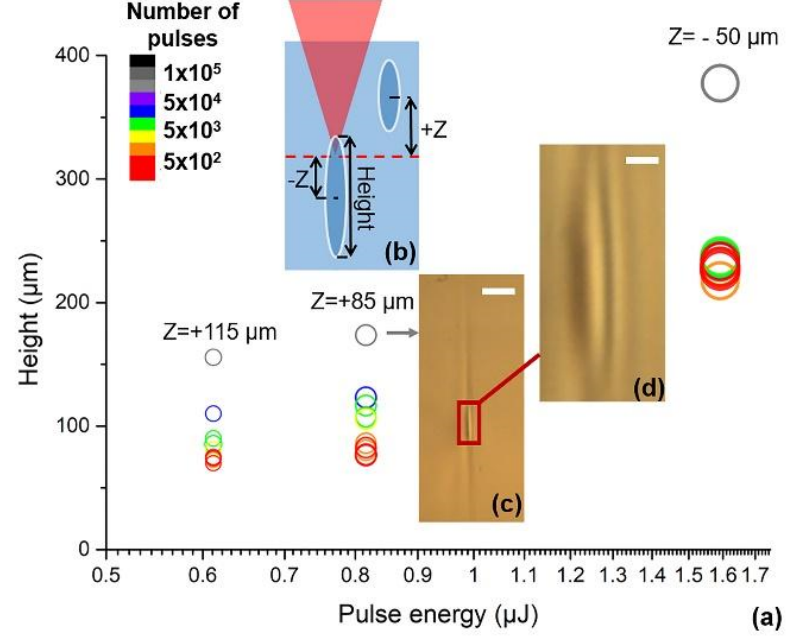
Figure 2. Measured height of waveguides at different pulse energy and number ( a ). Sketch map of laser inscribing and waveguide shift ( b ). The color legend of circles in ( a ) represents the number of laser pulses per region, where a smaller diameter means the maximum positive shift of the waveguide, which is schematically shown in ( b ). Transmission microscope photos of the waveguide fabricated by E p = 0.8 µ J and 10 5 pulses ( c ) and its enlarged view ( d ). The scale bars are 30 µ m ( c ) and 5 µ m ( d ).